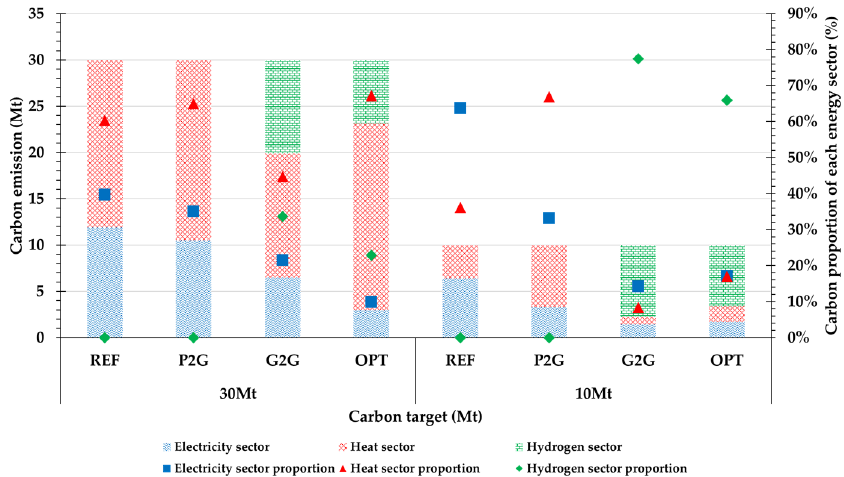
Figure 8. Carbon emission mix under different carbon targets.